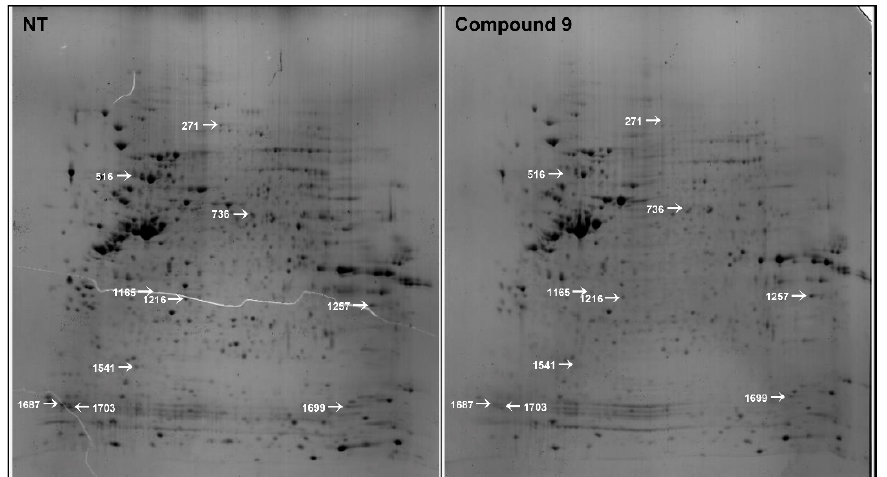
Figure 1. Two-dimensional gel images of AGS cells treated with or without compound 9. Total protein extracts were separated on pH 3.0–10.0 nonlinear IPG strips in the first dimension followed by 12% SDS-PAGE in the second dimension and visualized by CBB staining. Ten protein spots that were downregulated more than 3-fold by compound 9 (400 μ M) treatment were identified using MALDI-TOF MS analysis. The selected spots are marked with white arrows. Table 1. Ten protein spots identified by MALDI-TOF MS.